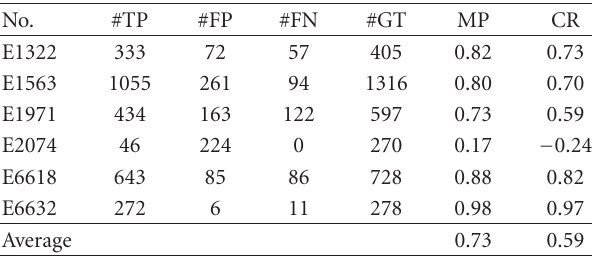
Table 5: The MP and CR value after SVM classifier.